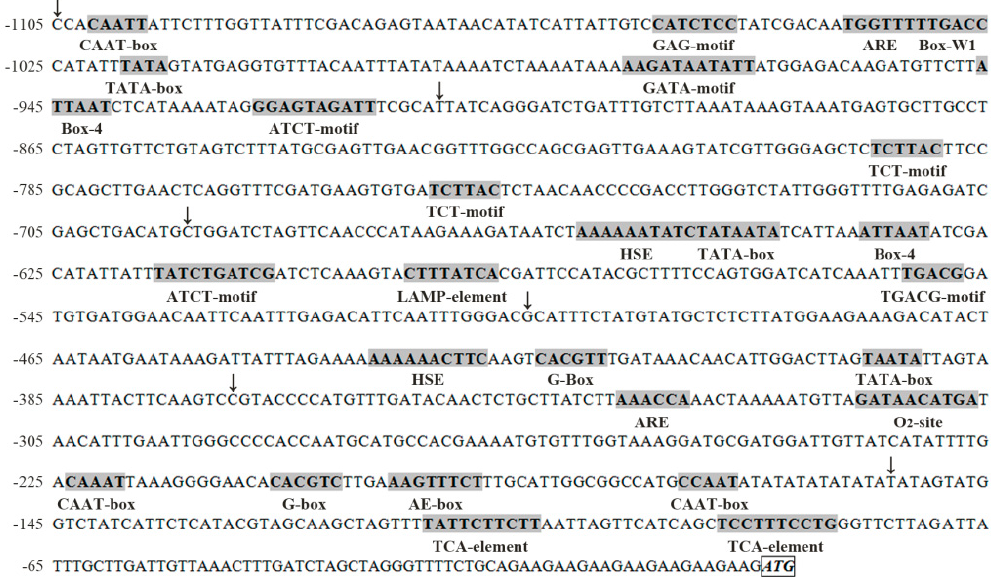
Figure 6. Nucleotide sequence of the DkLOX3 promoter. The DkLOX3 translational start codon ATG (bold, italic and boxed) numbered as ±1. Putative regulatory elements are shown in bold and shaded in grey; names are given below the elements. Arrowheads represent the starting point of 5 ′ -deleted derivatives.